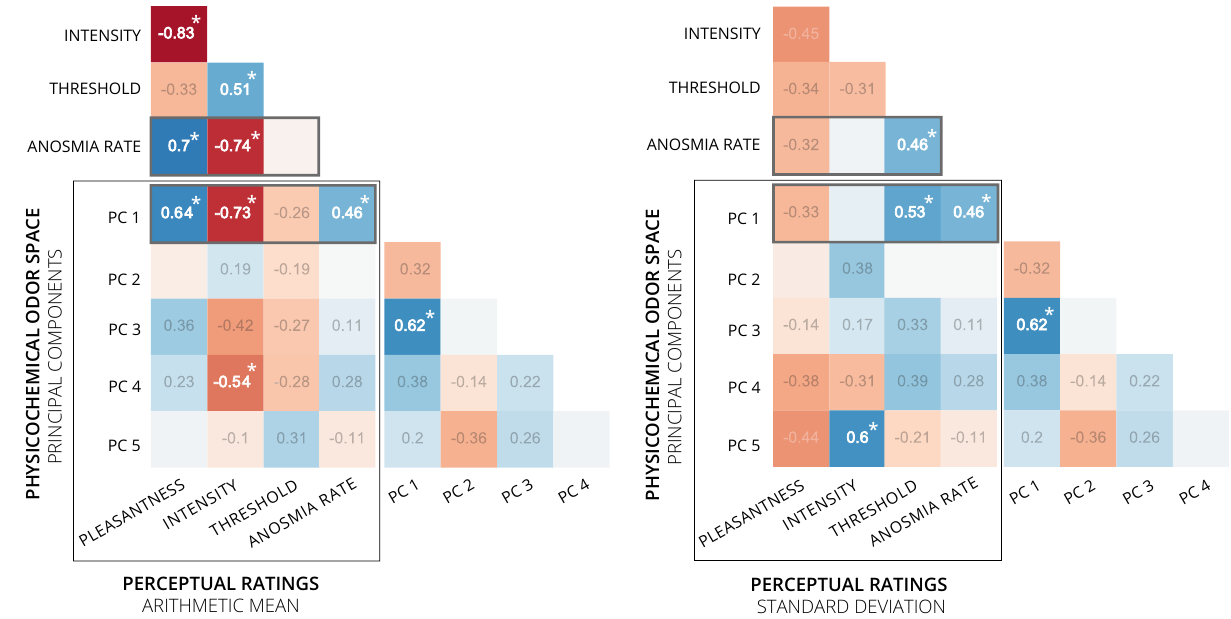
Figure 9. Correlation Matrices. Pearson correlation coefficients for associations between principal components (PC1 to PC5) from physicochemical odor space and arithmetic mean ( a ) and standard deviation ( b ) of perceptual ratings for pleasantness ( n = 13 odor molecules), intensity ( n = 13) and detection threshold ( n = 20). Highlighted in bold and with asterisk are significant correlations to the level of p < 0.05 (two-tailed t -test, uncorrected).